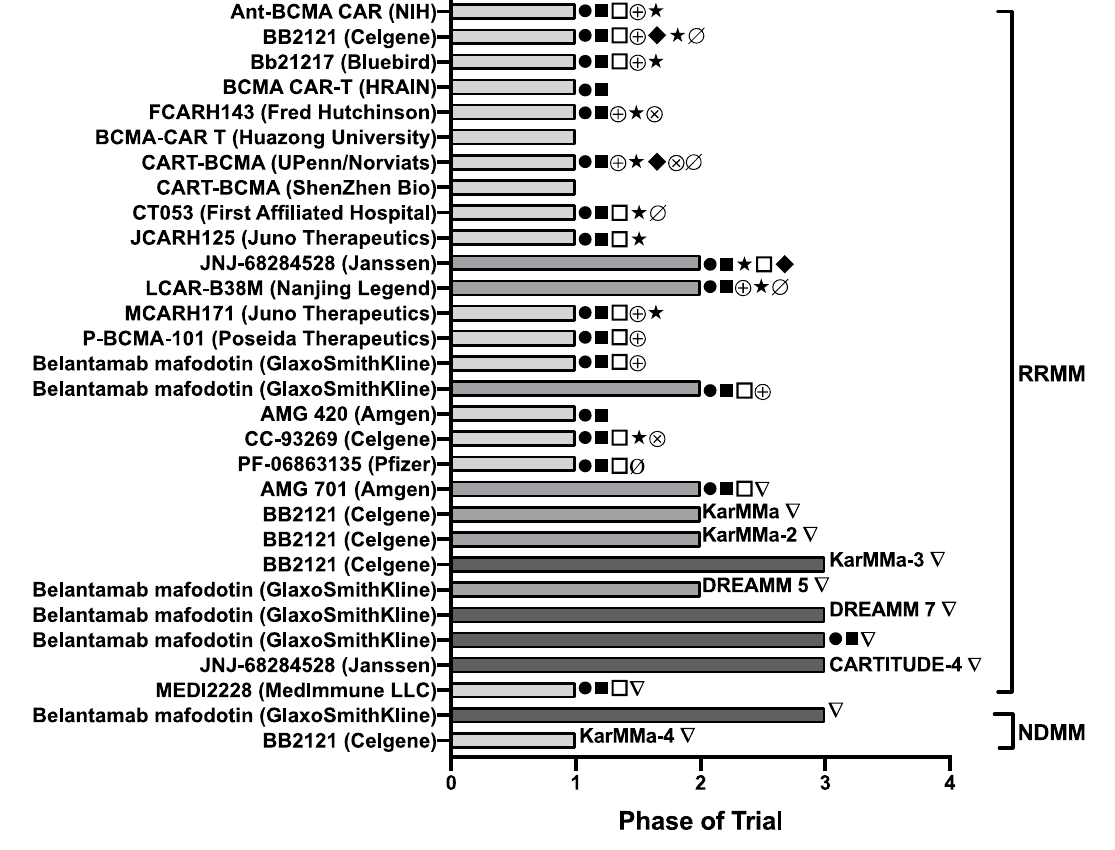
Figure 2. Immunotherapies targeting BCMA in clinical development. This figure shows various anti-BCMAagentsincurrentclinicaltrials. Themajorenrollmentcriteriaorcharacteristicsofparticipants are also indicated. Every e ff ort has been made to obtain reliable data from multiple sources including http: // clinicaltrials.gov / , company, and other web sites, but accuracy cannot be fully guaranteed to